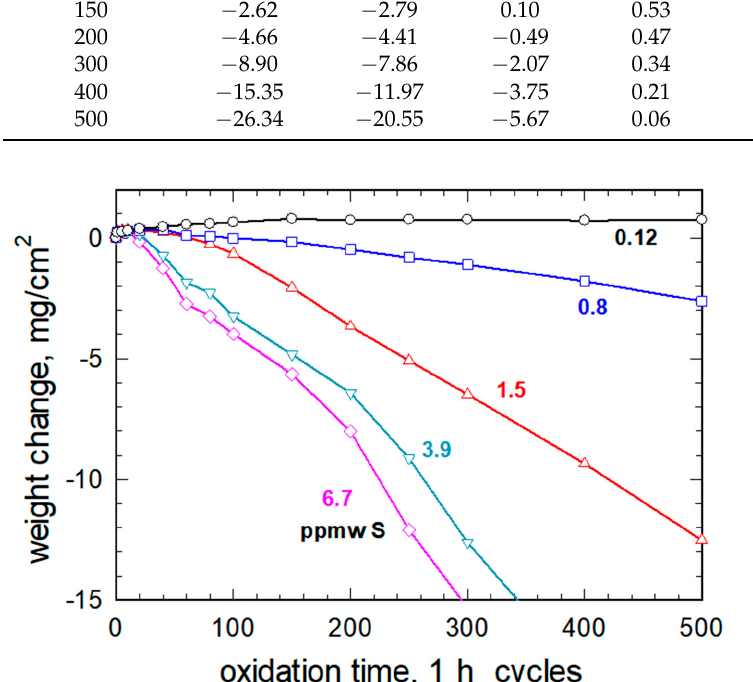
Figure 1. Selected family of 1100 °C, 1 h cyclic oxidation weight change curves for PWA 1480, showing increased attack with sulfur content and excellent scale-adhesion behavior at the 0.1 ppmw S level [6] (Curves correspond to samples 50-5, 20-5, 50-3, 20-1, and 20-0).